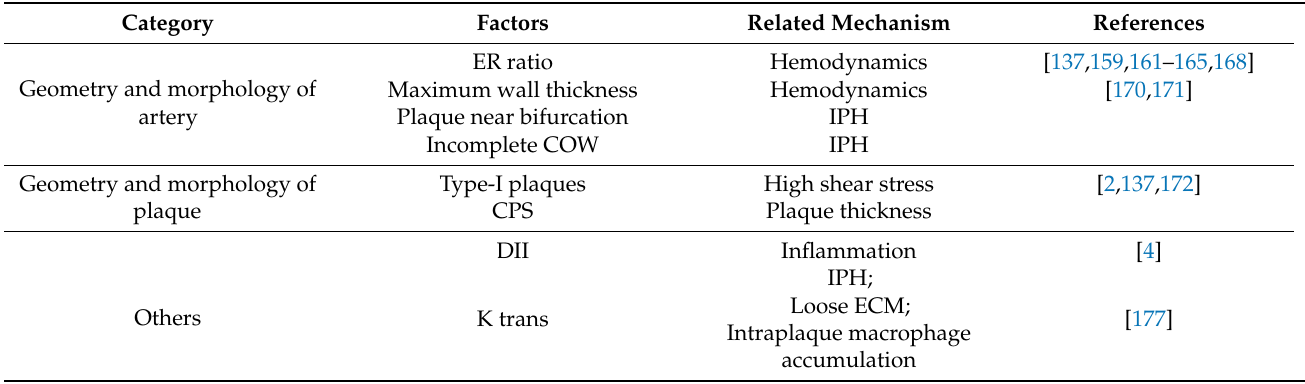
Table 3. Macroscopic factors that potentially predict vulnerable